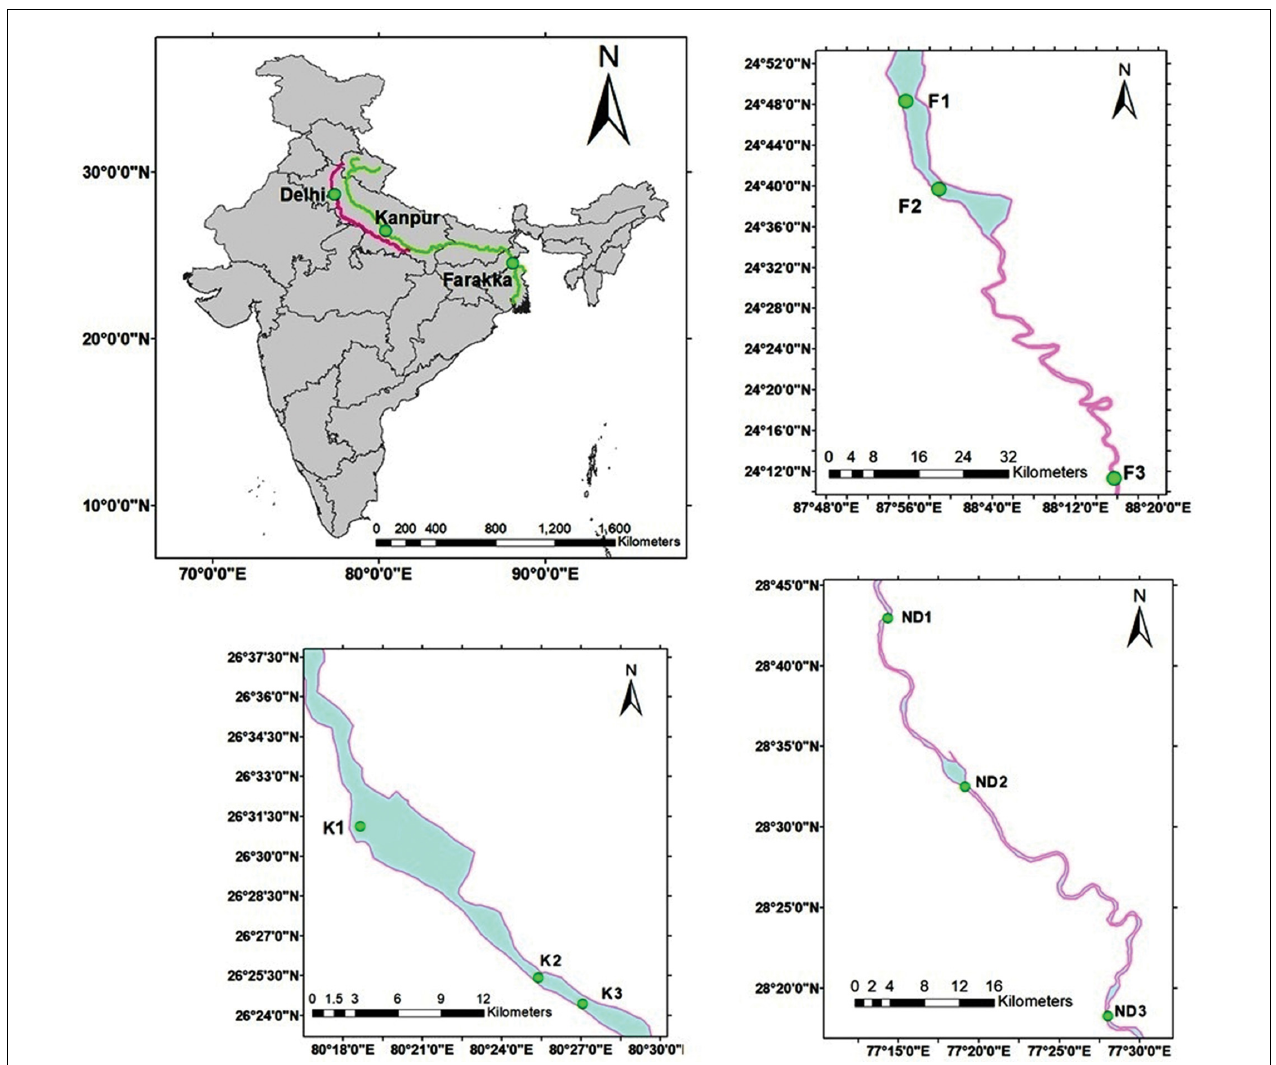
FIGURE 1 | Map showing the sediment sampling sites. Sediments were collected from the river Ganga at six locations namely, K1 (Nawabganj, Kanpur), K2 (Jajmau, Kanpur), K3 (Jana village, Kanpur), F1 (Below Farakka bridge, West Bengal), F2 (Paharghati, West Bengal), and F3 (Lalbag, West Bengal) whereas, three locations from the river Yamuna viz. ND1 (Wazaribad, New Delhi), ND2 (Okhla Barrage, New Delhi), and ND3 (Faizupur Khadar, New